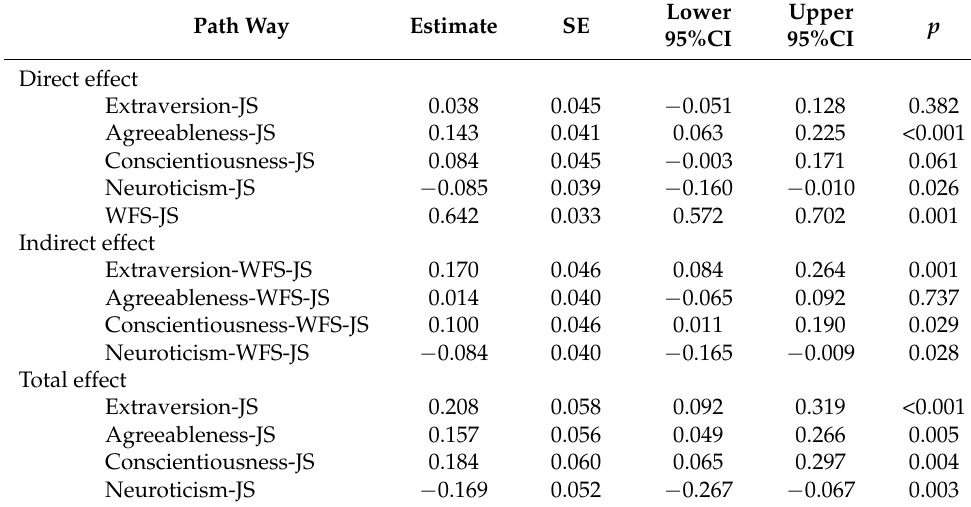
Table 4. Bootstrap analysis ( N =